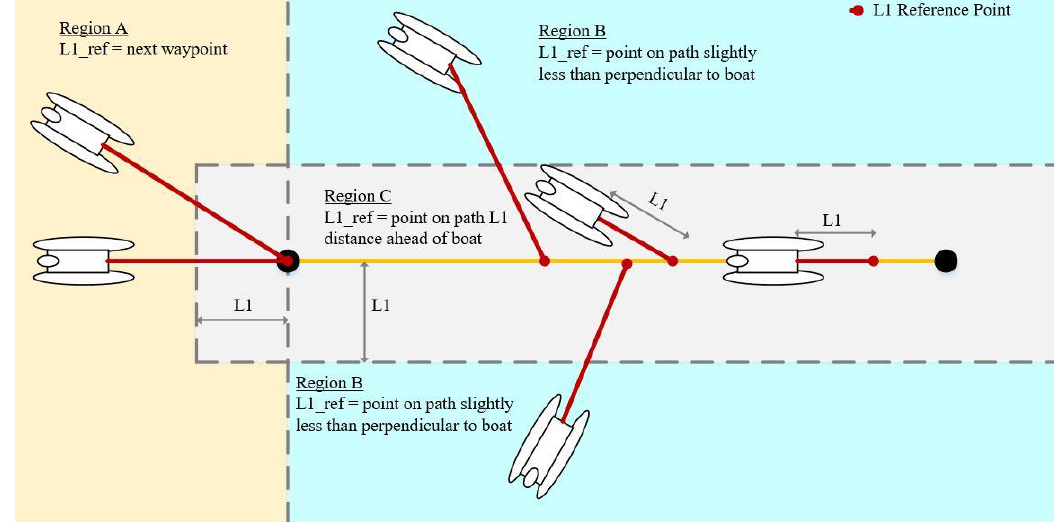
Figure 10. L1 tracking schematic showing computation of reference point (L1_ref) at various vehicle positions with respect to the desired path.